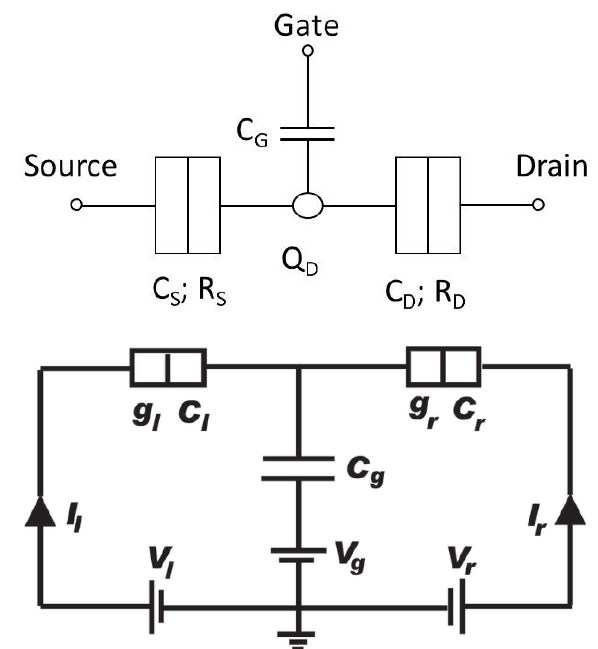
Figure 1. Symbolic representation and equivalent circuit of SET